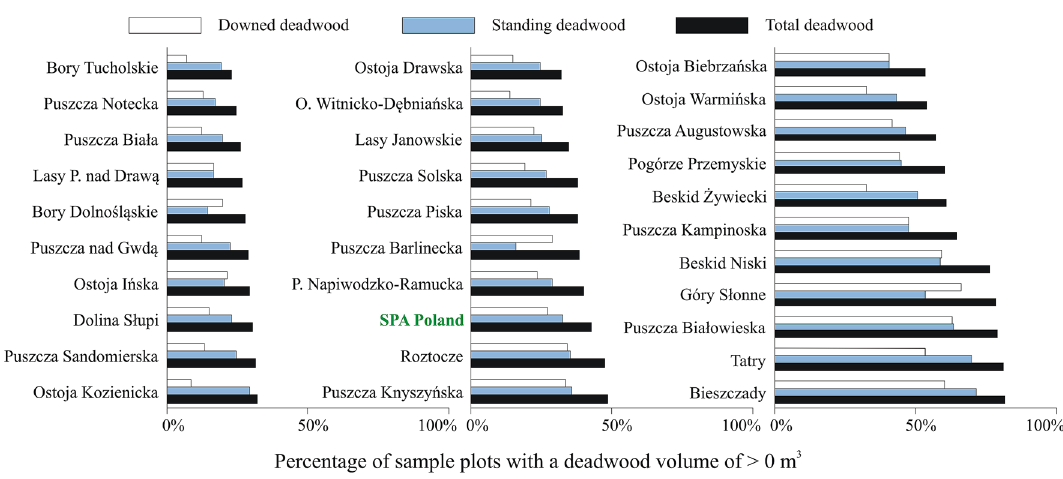
Figure 4. Percentage of sample plots in individual SPAs with a volume of downed, standing, and total (downed or standing) deadwood of > 0 m 3